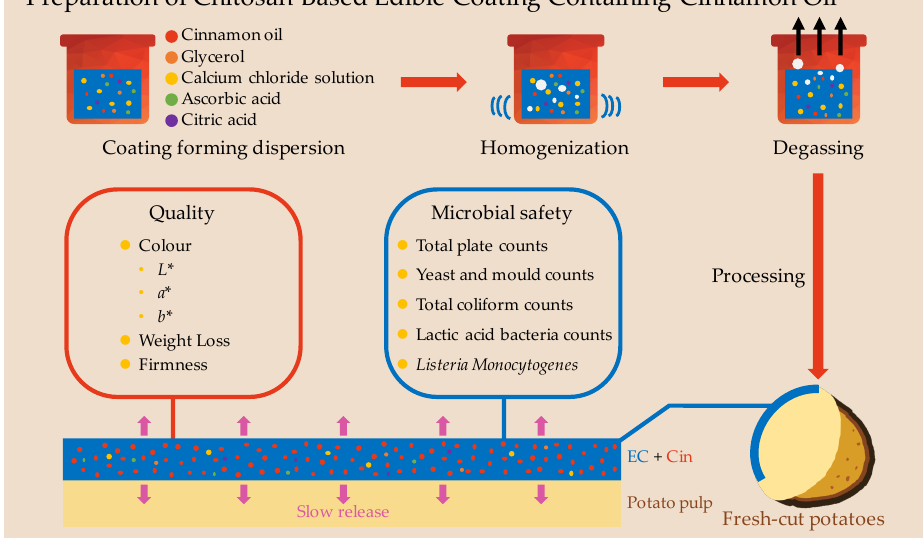
Figure 1. Diagram of experimental